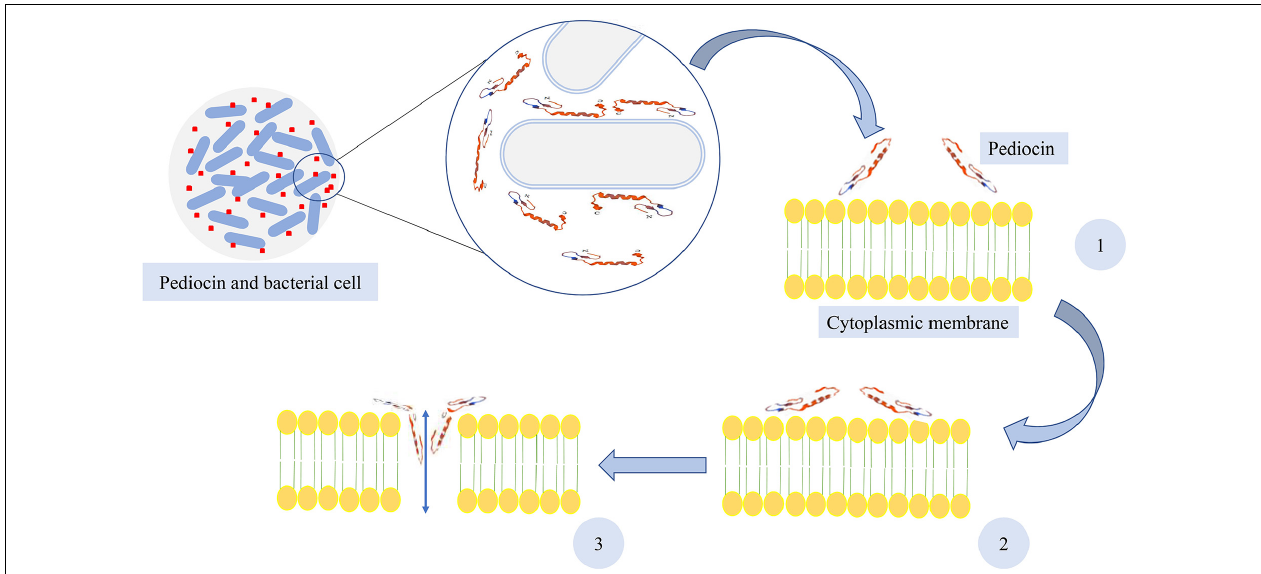
FIGURE 2 | Pore formation of pediocin in bacterial cell membrane. (1) Adsorption of pediocin, (2) distribution and interaction of pediocin on the surface of the cytoplasmic membrane, and (3) pore formation in the